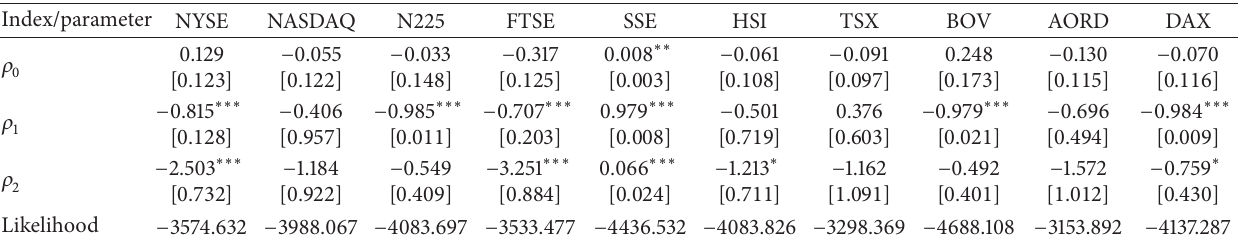
Table 2: Results of TVRA-GARCH-M model